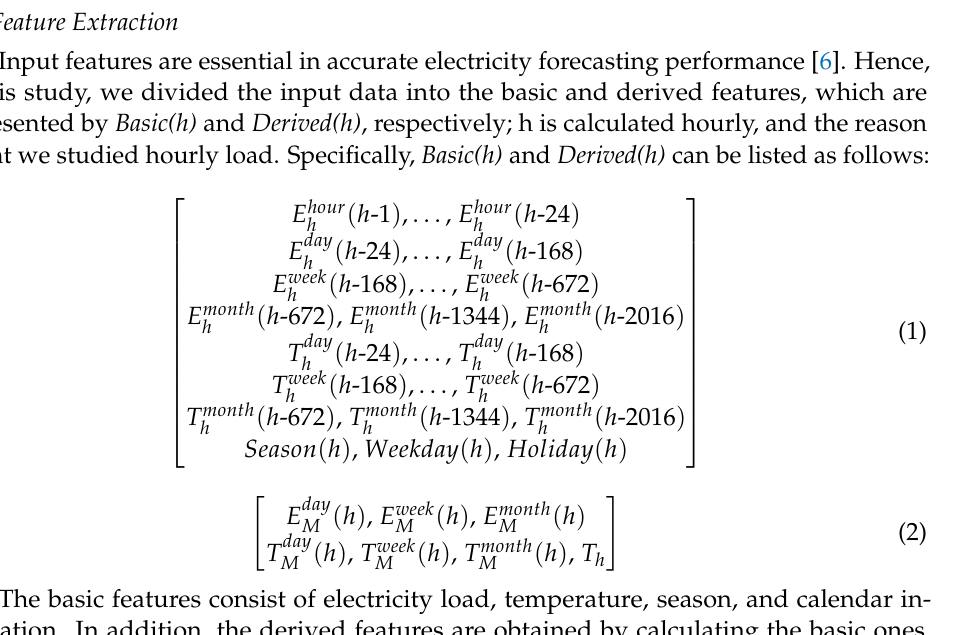
Figure 1. The proposed four-stage forecast model including feature extraction, DCRB, Bi-LSTM layer, and ensemble structure: DCRB, densely connected residual block.